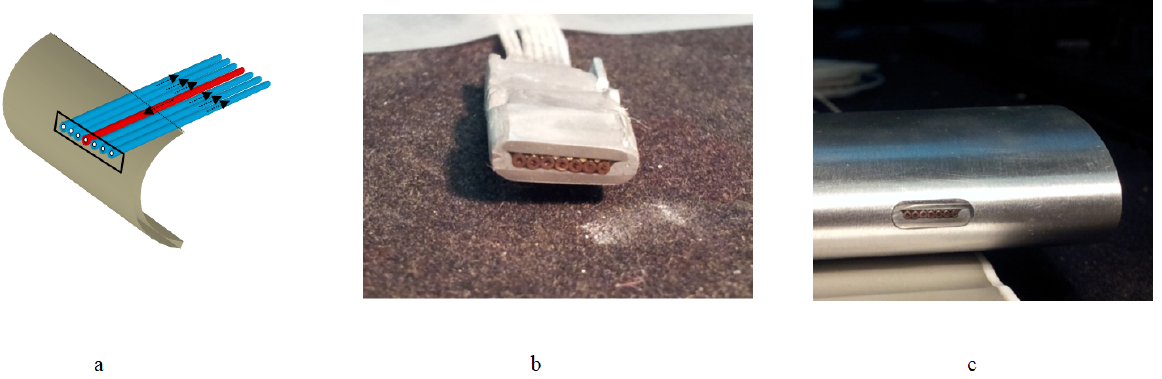
Figure 2. ( a ) Schematic diagram of Fiber optics array ice sensor (FOAIS). ( b ) Picture of the sensor. ( c ) Ice sensor on leading edge of the wing with window.